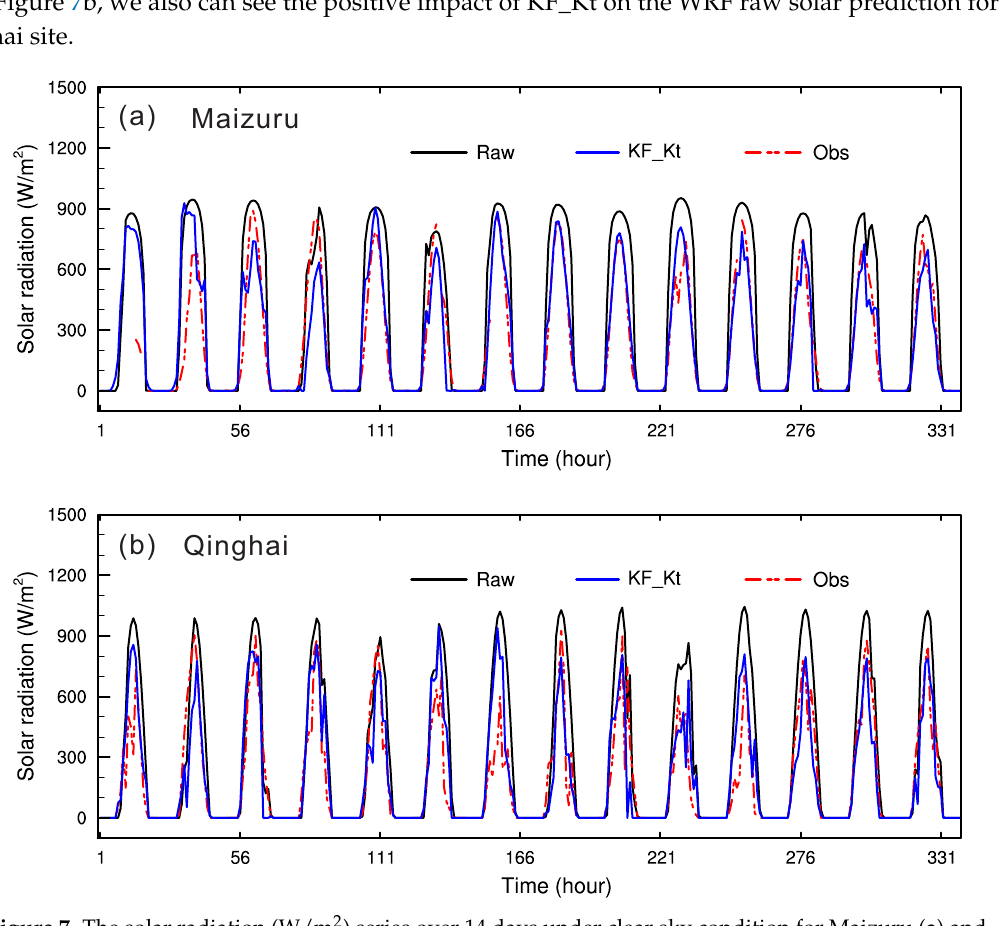
Figure 7. The solar radiation (W/m 2 ) series over 14 days under clear sky condition for Maizuru ( a ) and Qinghai sites ( b ). The solid black, blue and dotted red lines stand for WRF raw forecasts, KF_Kt forecasts and the corresponding observations,